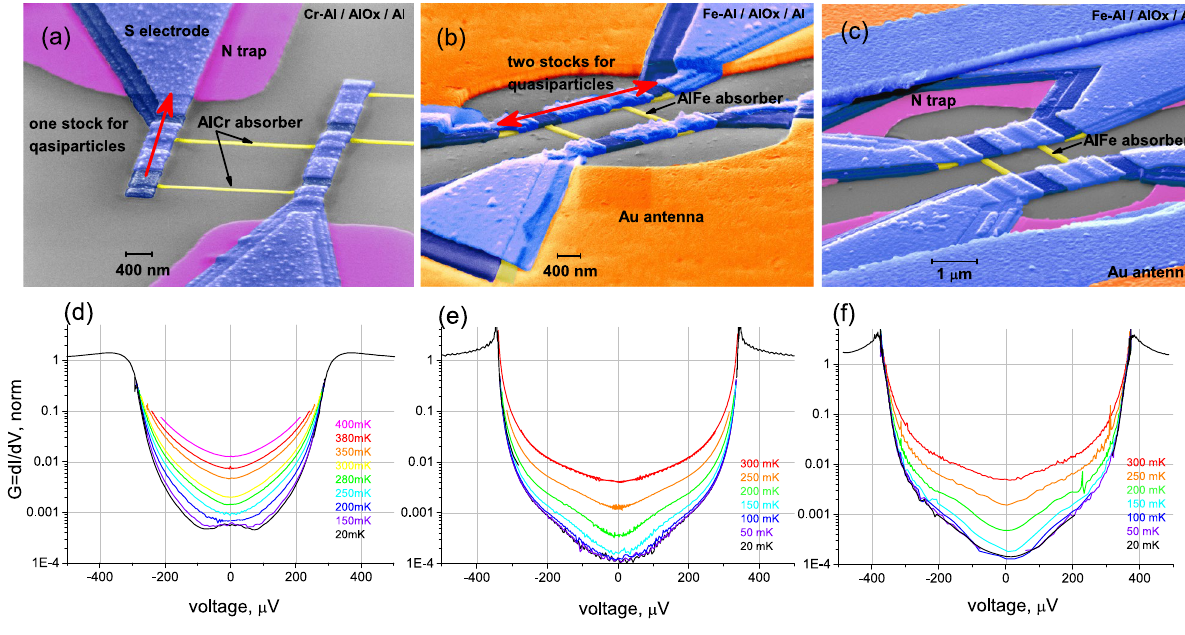
Figure 2. SEM images of the sample designs with one stock and normal metal traps for quasiparticles ( a ), with two stocks and without traps ( b ) and with two stocks and normal metal traps ( c ). Here the gold antennas are shown in orange, the superconductors in blue, the N traps in magenta, and the absorber in yellow, with a typical 3 80 nm 3 1000 nm 3 . Red arrows in ( a , b ) show the possible directions volume of its narrow part of 15 nm × × for quasiparticles to move. In ( a ), there is only one direction, which results in the S electrode overheating. Plots on ( d , e , f ) are differential conductivities of the samples A , B , and C , at various temperatures, respectively. In ( d ), the presence of Andreev current I A is evident below 150 mK as a slight peak at zero voltage. In ( e , f ), there is no visible sign of I A down to 20 mK. Much better electron cooling is seen in ( e , f ) in comparison with ( d